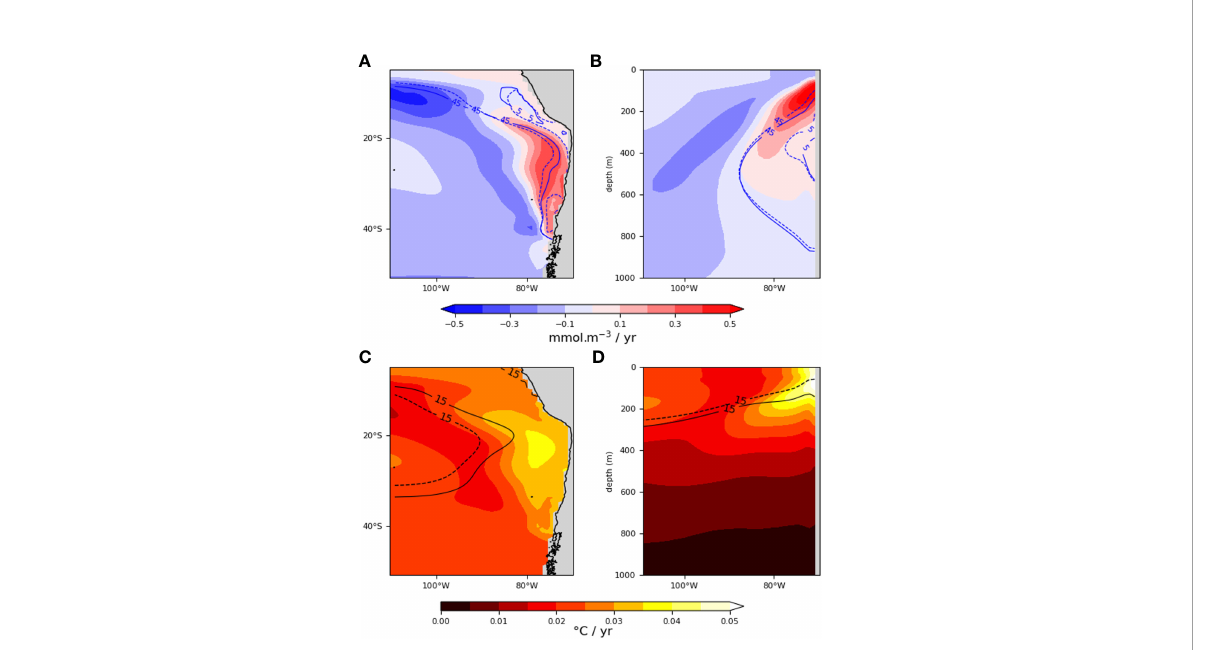
FIGURE 1 Ensemble mean of oxygen and temperature trends between 2006 and 2100. At 200m (A, C) and 26°S (B, D) . For oxygen (top panels), the blue lines represent the projected oxygen isocontours (5 and 45 mmol.m -3 ) for the “ present ” (mean 2006-2036, dashed) and “ future ” climates (mean 2070-2100, solid). For temperature trends (bottom panels), the black lines represent the projected temperature isocontours (15°C) for present (dashed) and future (plain)